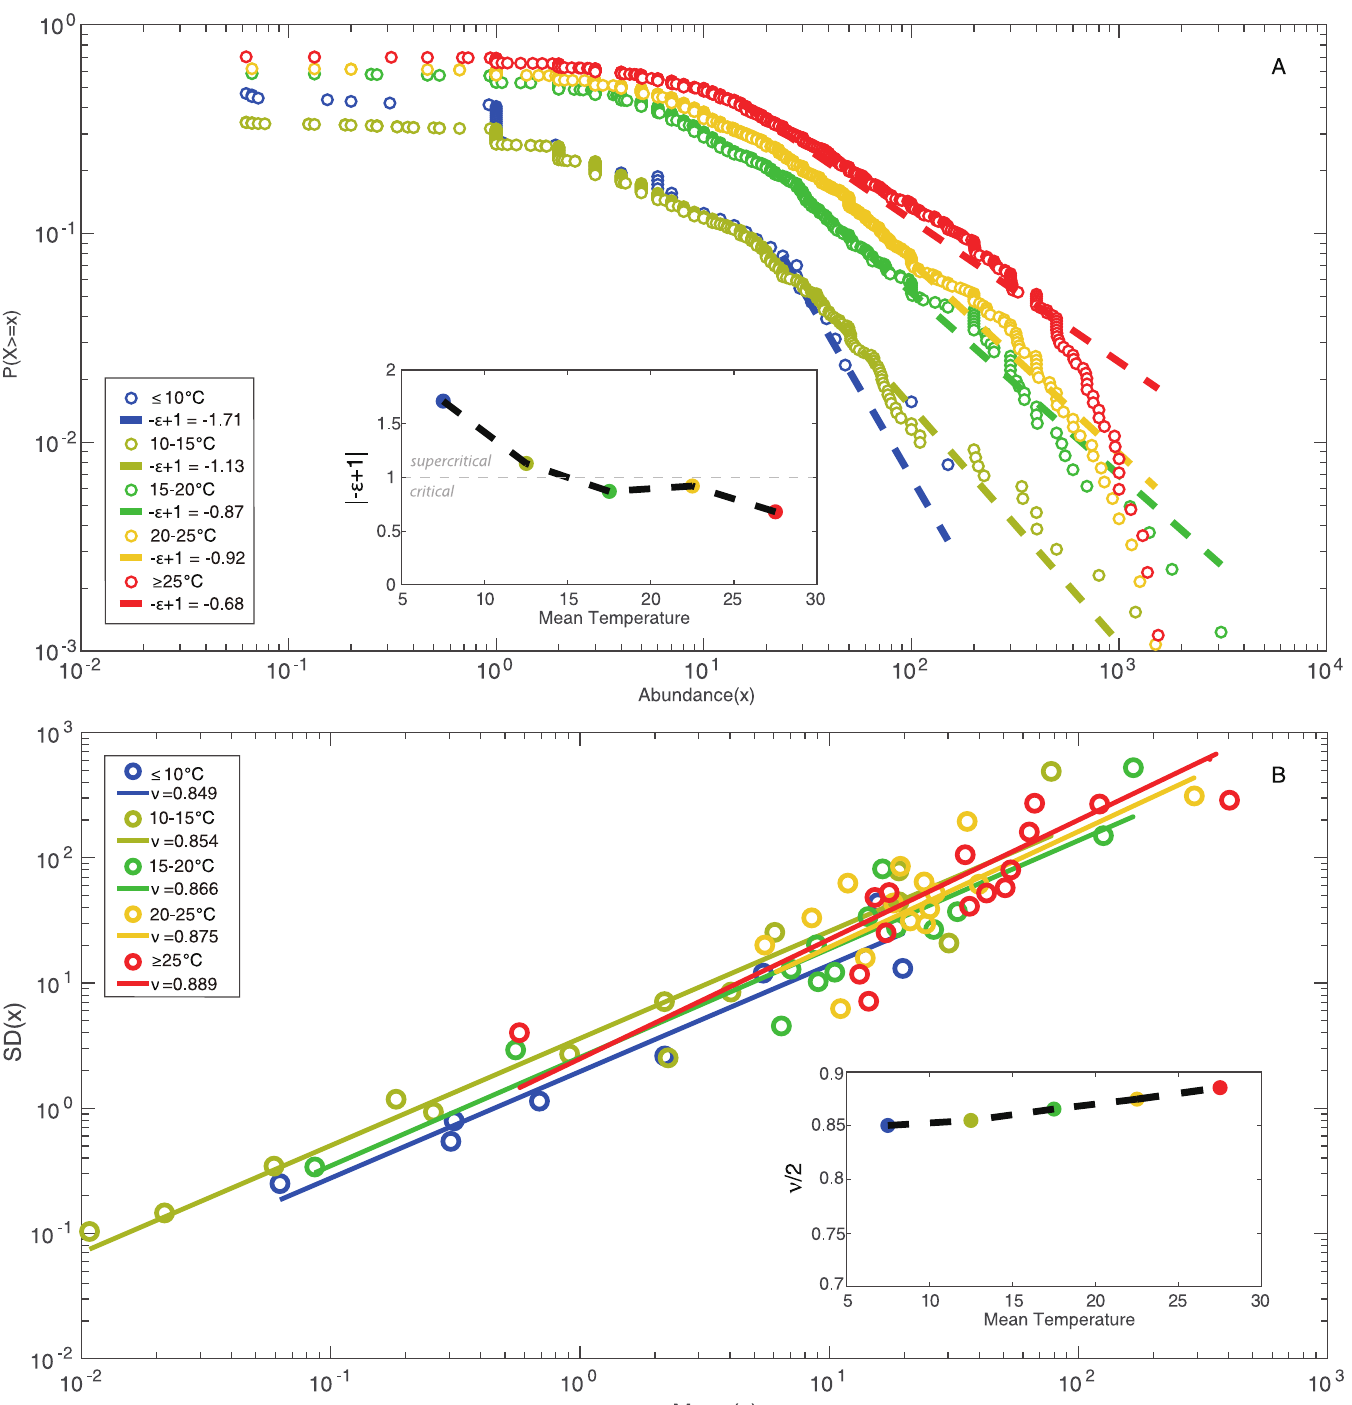
Fig 3. Zipf’s and Taylor’s law of species abundance for temperature groups. A : Exceedance probability distribution functions (epdf) are fitted by power-law distributions. | − � + 1| is the scaling exponent of the distribution. B : Taylor’s law as scaling law between standard deviation and mean species abundance for five TRs; ν /2 is the scaling exponent of Taylor’s law that is typically construed by using the variance [72], h x 2 i * h x i ν ; smaller ν means that fluctuations in abundance are more even and species are more regularly distributed; vice versa, species are more power-law distributed (as supported by Zip’s law) driven by stronger environmental effects [85] (in this case ST) determining portfolio effects with potential stabilizing effects [86] (this however neglects interaction topology). All exponents for five TRs are interpolated by black dashed lines in insets to emphasize abundance patterns transitions across TRs/seasons; transitions show a gradual second-order phase transition with higher Pareto-distributed fluctuations for higher